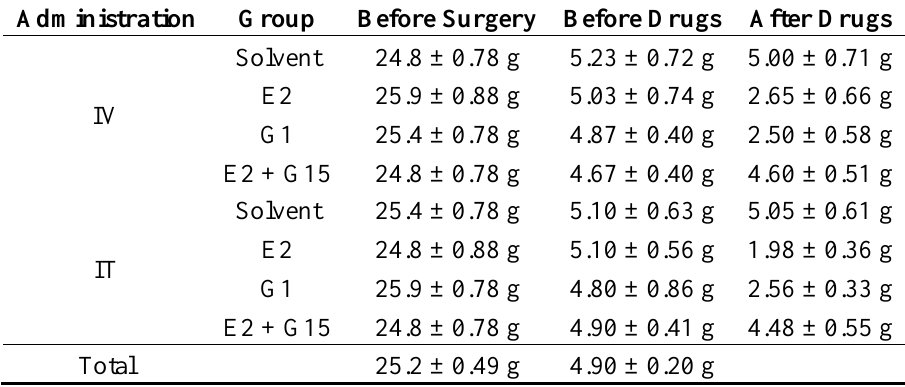
Table 1. The paw withdrawal threshold (PWT) of all the groups, before surgery, before drugs and after